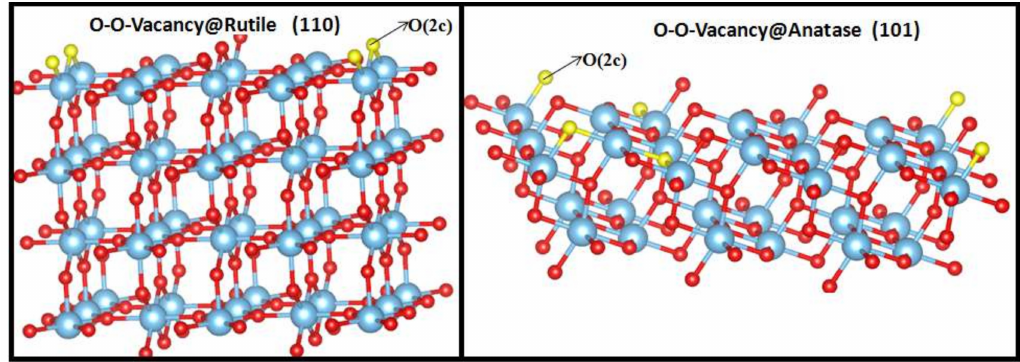
Figure 5. The most stable structures O-O-vacancy@rutile (110) and anatase (101) surfaces. Red and blue spheres represent O and Ti atoms, respectively, and yellow spheres represent O-vacancy